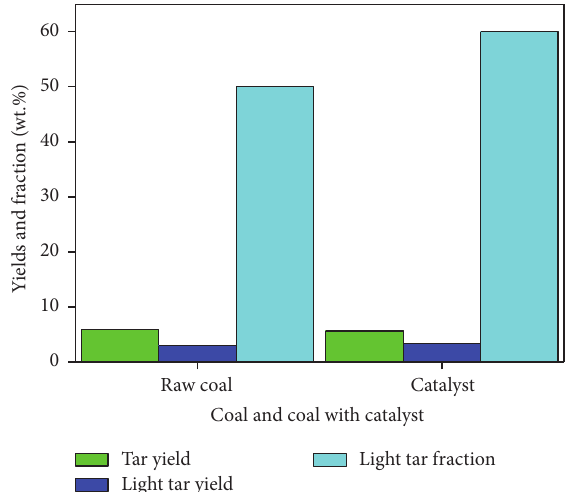
Figure 8: Yields and fraction of coal pyrolysis tar without and with